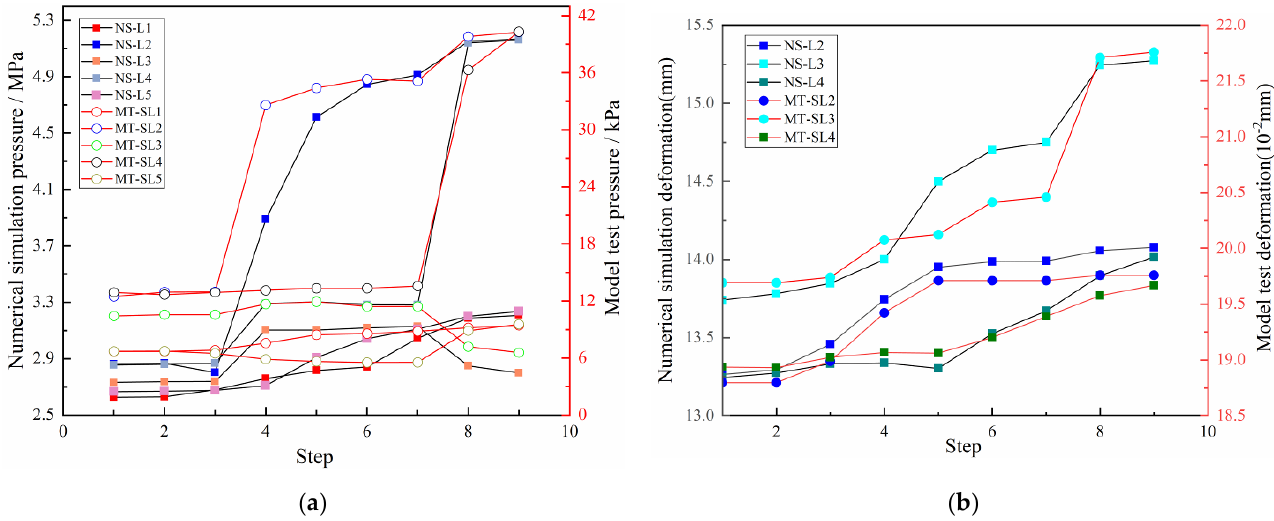
Figure 15. Comparative analysis of the surrounding rock construction response: ( a ) surrounding rock pressure and ( b ) surrounding rock displacement.